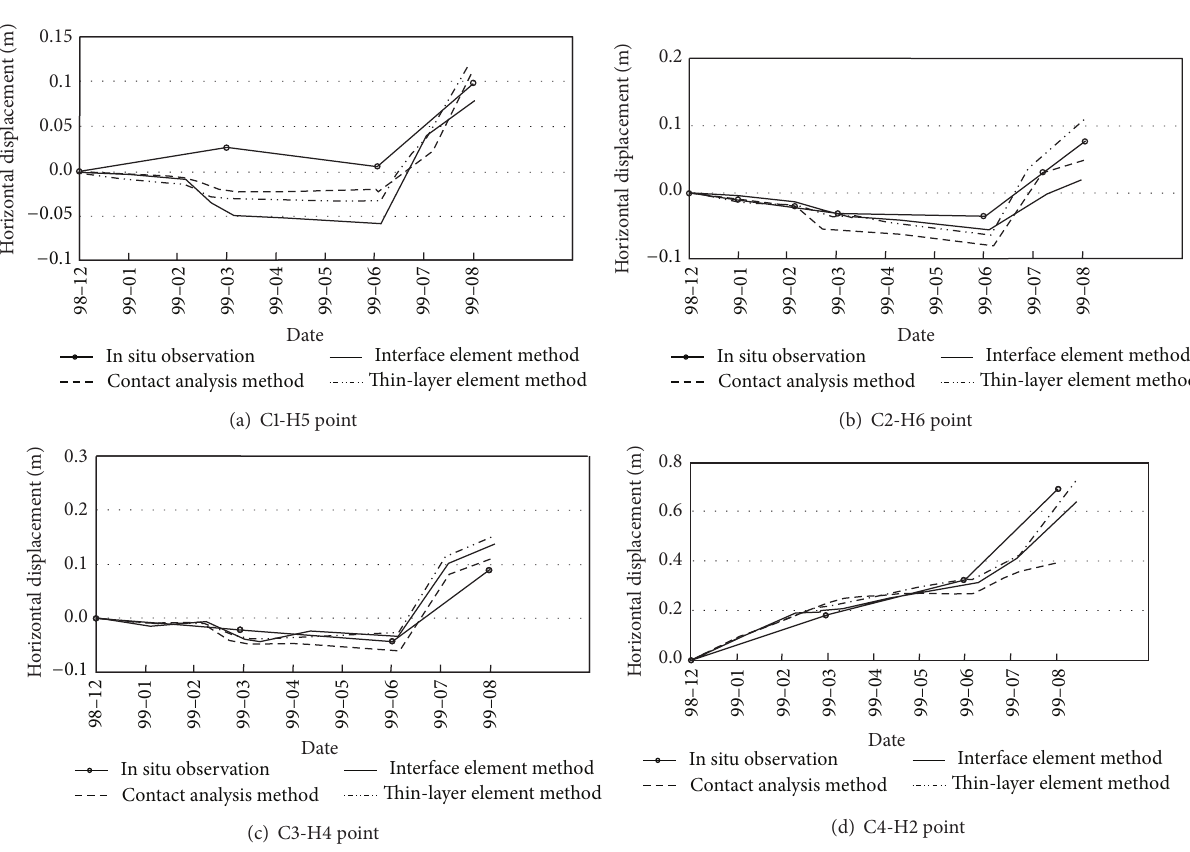
Figure 10: Horizontal displacement of the dam body along the